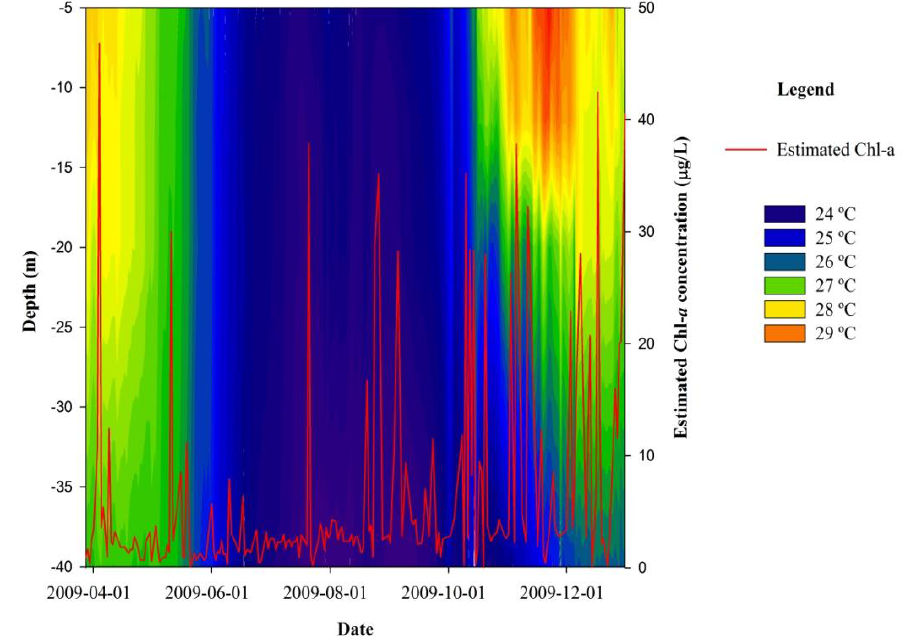
Figure 5. Water column temperature and estimated chl- a